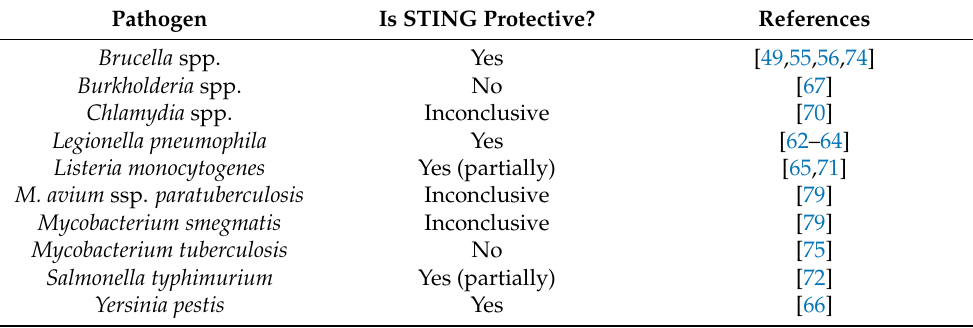
Table 1. The relevance of STING activation in bacterial infections addressed in this review. Pathogen Is STING